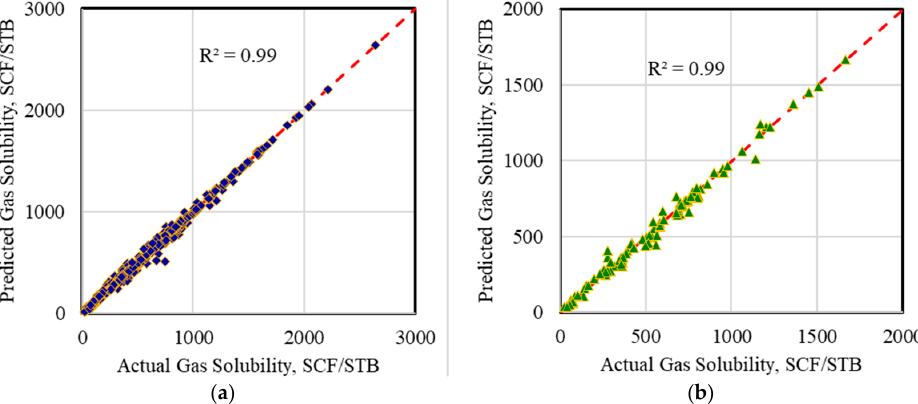
Figure 6. Cross plot between the real Rs and the values predicted using the SaDE-ANN model. ( a ) Training data; and ( b ) testing data.